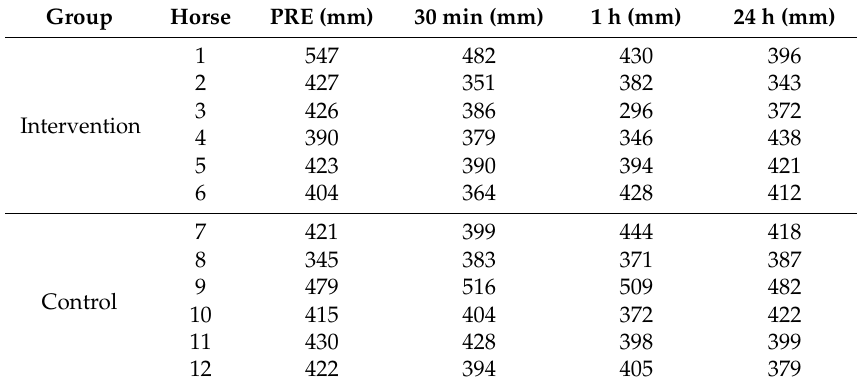
Table 1. Individual horse summed measurements in millimetres (mm) at time periods: before (PRE), thirty minutes, one hour and twenty-four hours after dynamic mobilisation exercises (DME). Group Horse PRE (mm) 30 min